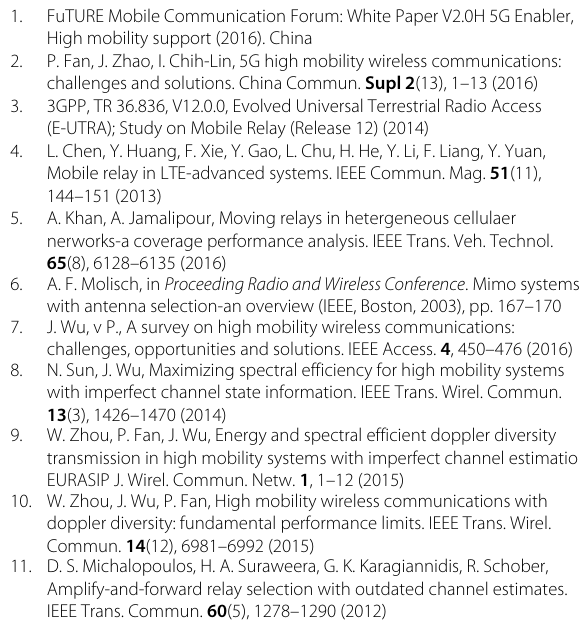
Doppler spread and SNR. The impacts of channel estima- tion errors and the geometric layout of the antenna on the performance of antenna selections were studied by devel- oping several performance metrics, including the outage probability, the average SER, a spectral efficiency lower bound, and the switching rate. Both analytical and simula- tion results demonstrated that channel estimation errors have significant impact on the performance of systems with distributed antenna